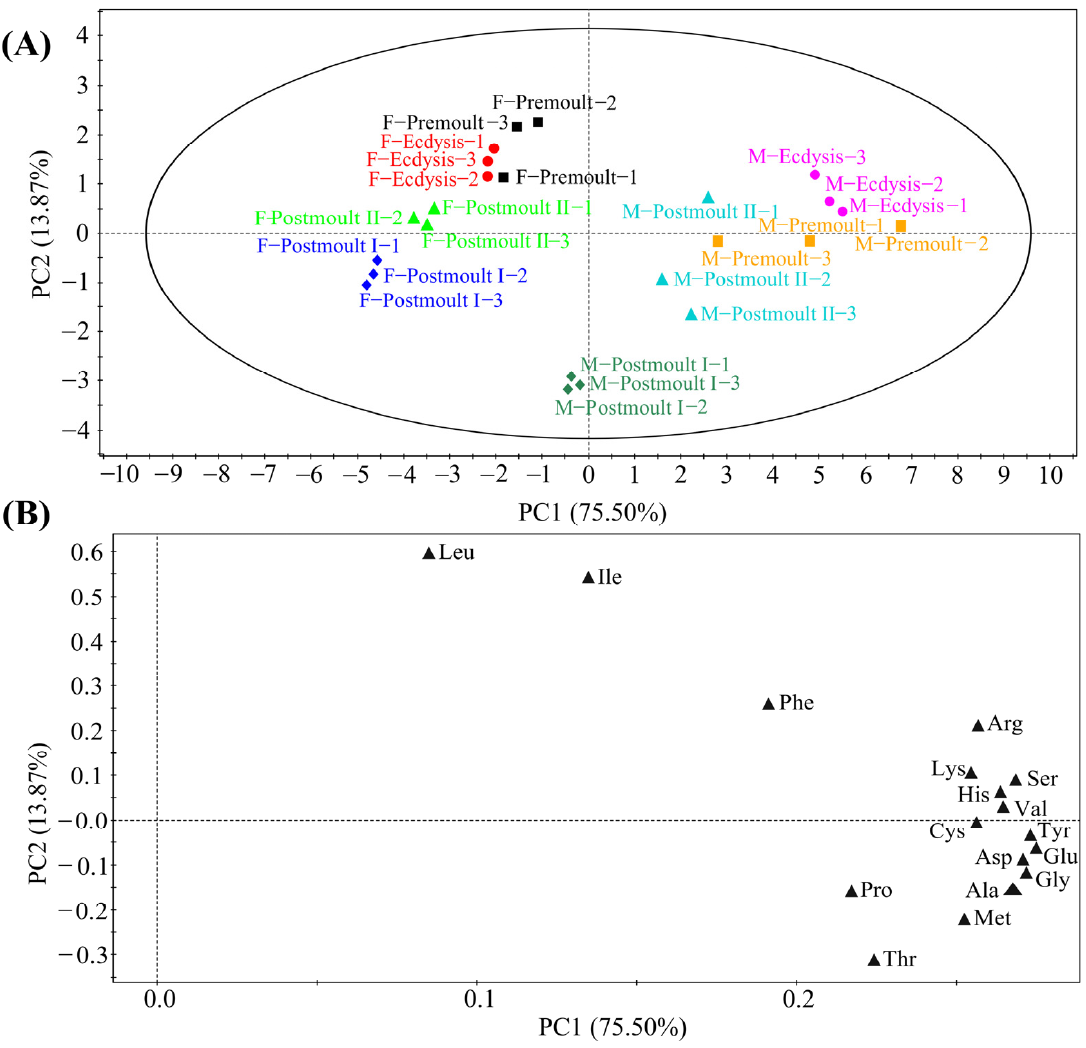
Figure 6. Principal component analysis (PCA) score plot ( A ) and loading plot ( B ) based on the amino acid composition of mud crab.